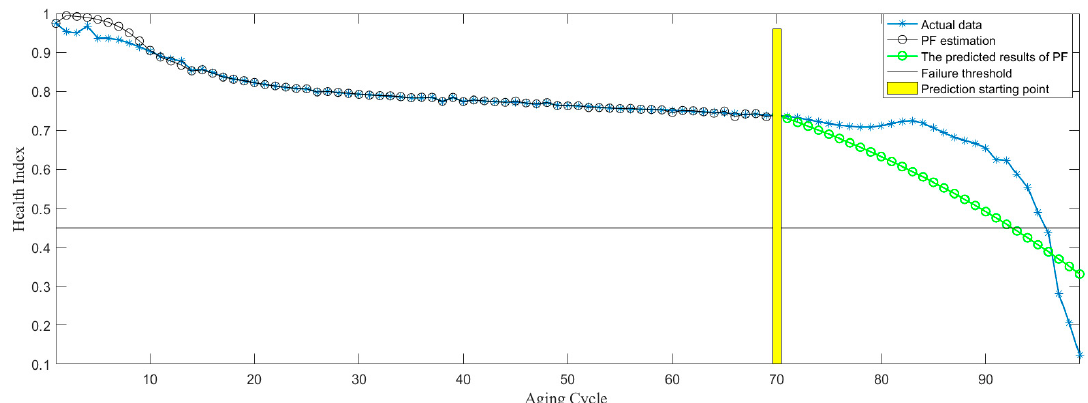
Figure 15. RUL prediction based on starting point 70 cycle.